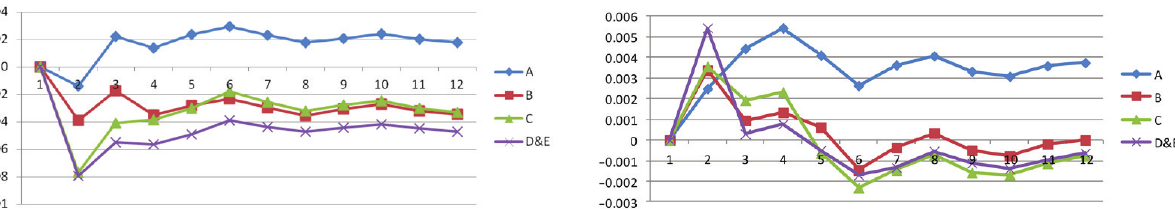
Figure 8h. Accumulated impulse response of PPI to shocks in housing supply